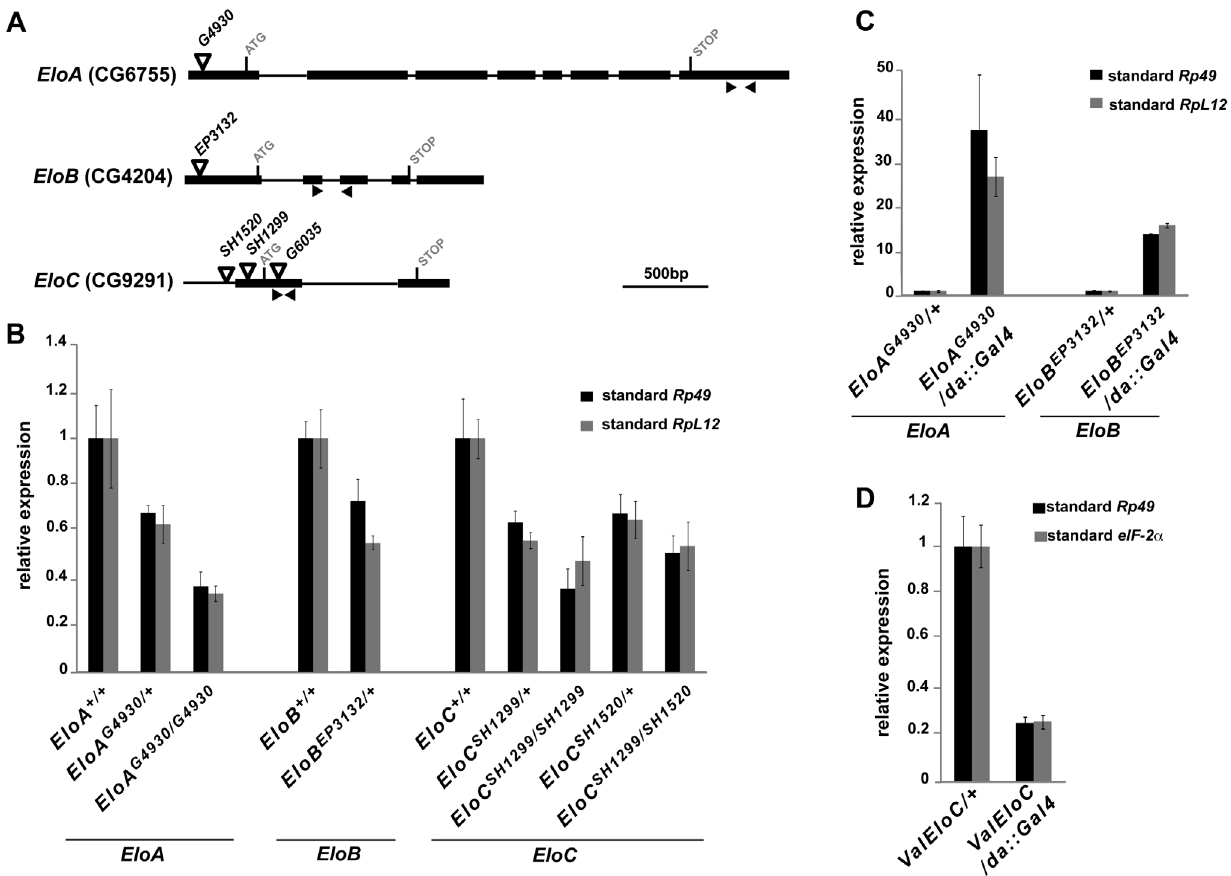
Figure 3. Deregulation of EloA,EloB or EloC expression using P -element insertion lines. (A): Structure of EloA , EloB and EloC genes showing localization of the P -elements used in this study. Exons are represented by boxes, and introns by lines. Black arrowheads show positions of primer pairs used to quantify Elo gene expression. (B): Quantification of Elo gene expression in EloA G4930 , EloB EP3132 , EloC SH1520 or EloC SH1299 homozygous or heterozygous larvae. (C): Quantification of Elo gene expression in da::Gal4 .. EloA G4930 or da::Gal4 .. EloB EP3132 larvae. (D): Quantification of EloC expression in da::Gal4 .. ValEloC embryos. Relative Elo expression levels were obtained by normalization to Rp49 (black bars, B to D), RpL12 (grey bars, B, C) or eIF-2 a (grey bars, D).